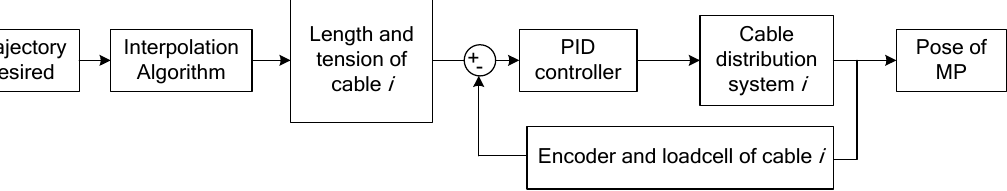
Figure 15. Structure of the position controller of the CDPRs.